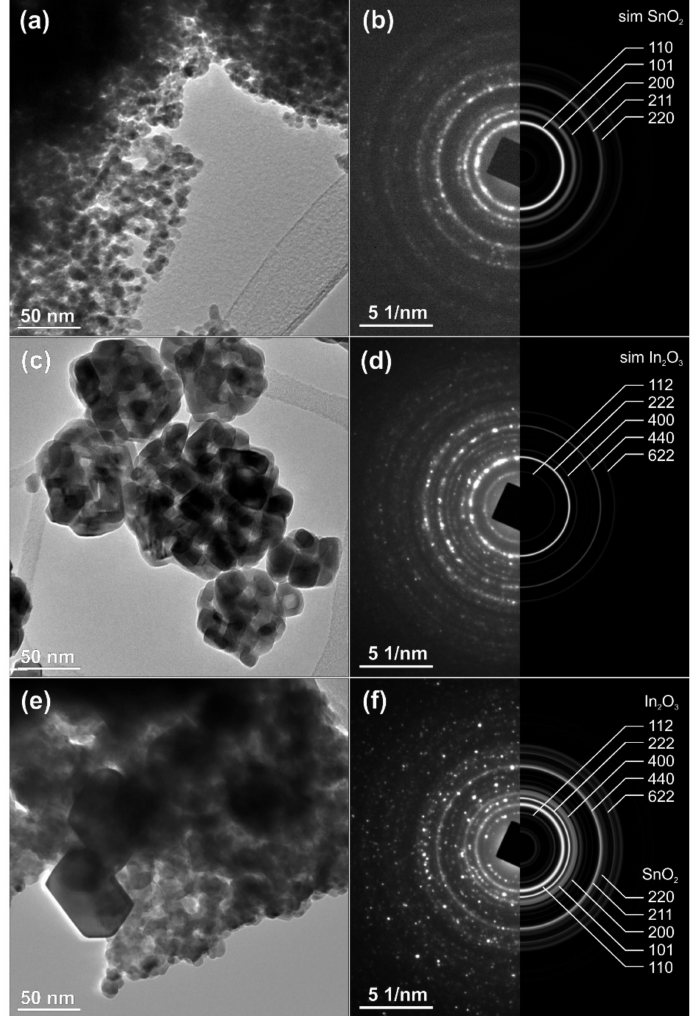
Figure 4. TEM analysis of SnO 2 -In 2 O 3 nano-composite powder ( a , b ) HRTEM and SEAD image of SnO 2 powder, ( c , d ) TEM and SEAD images of In 2 O 3 powder, ( e , f ) TEM and SEAD images of SnO 2 -In 2 O 3 (85:15 wt%) nano powders,